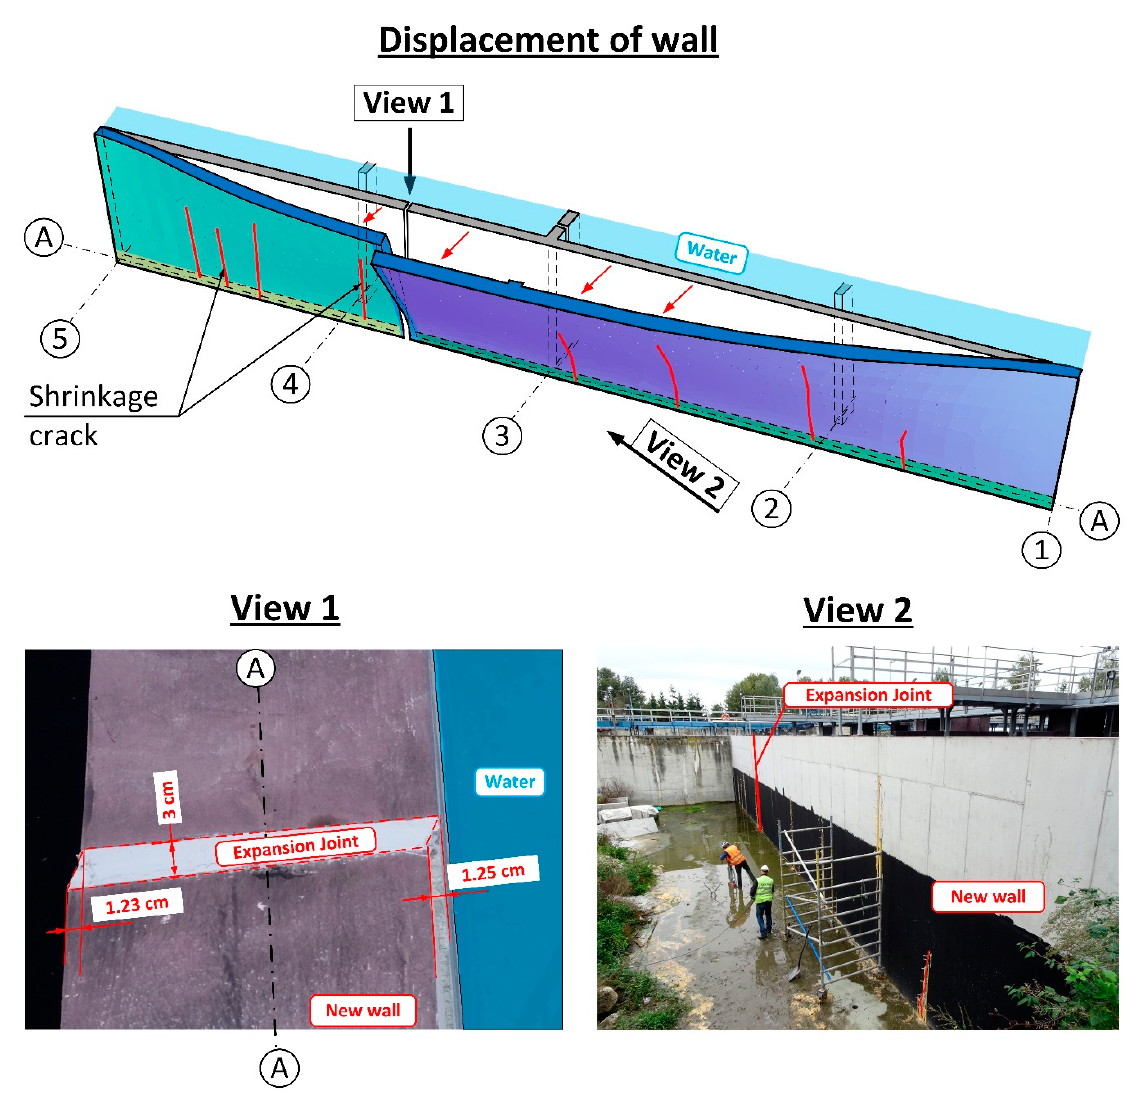
Figure 6. Wall displacement on Axis A following termination of leak testing. Destruction of the seals of the expansion joint (dilation) of the wall on the 3 axes.